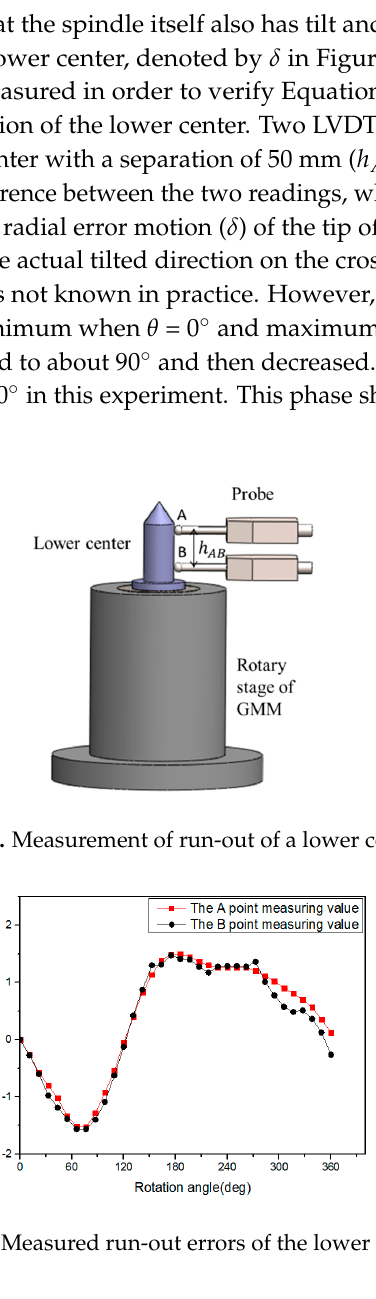
Figure 8. Measured run-out errors of the lower center.